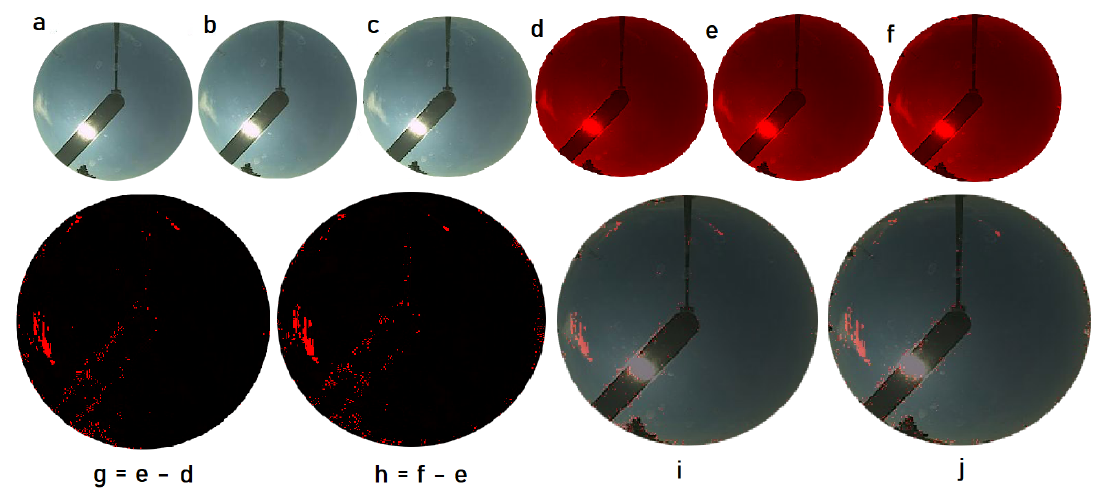
Figure 3. ( a ) = 20160219201500, ( b ) = 20160219201600, ( c ) = 20160219201700; ( g ) = subtraction between ( e ) and ( d ), ( h ) = subtraction between ( f ) and ( e ), ( i ) and ( j ) show the cloud front displacement over the original